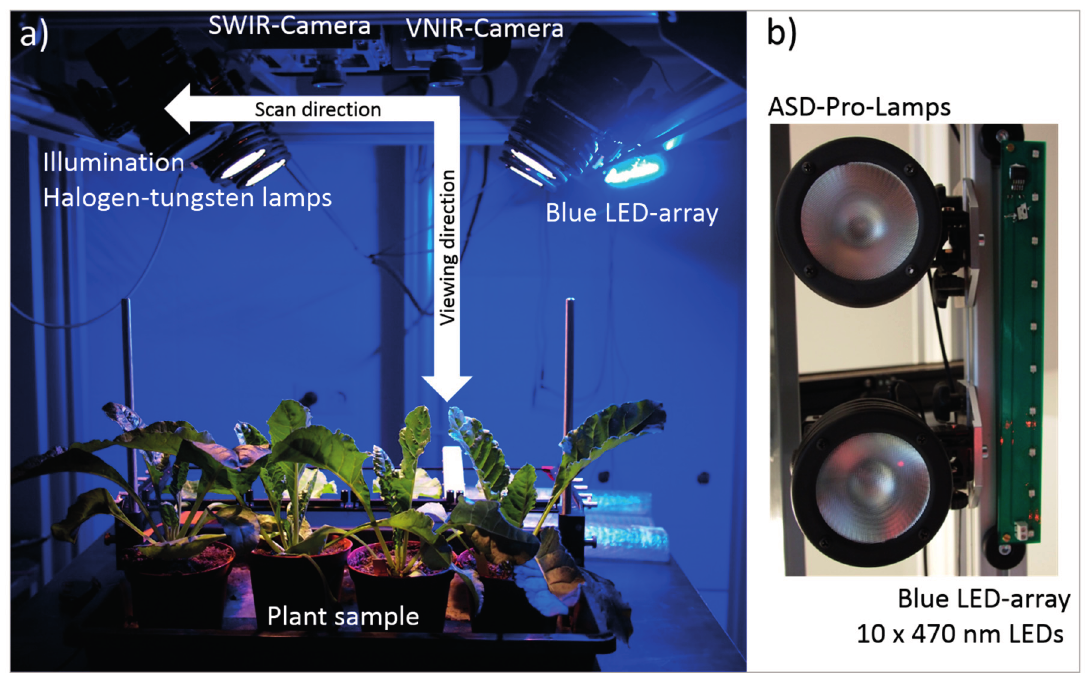
Figure 1. ( a ) Hyperspectral imaging setup for measurements of the reflectance of plants under controlled conditions with artificial illumination; and ( b ) installation of the supplemental Blue LED-array next to the ASD-Pro-Lamps. (Best viewed in